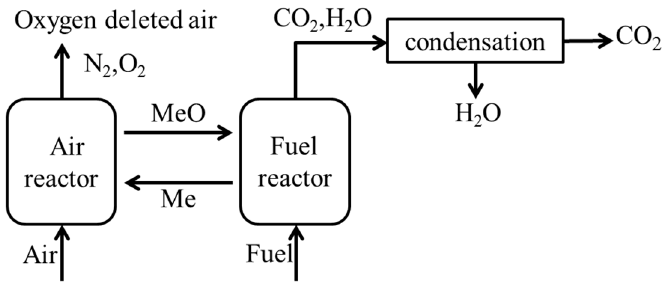
Figure 1. Schematic of chemical ‐ looping combustion.